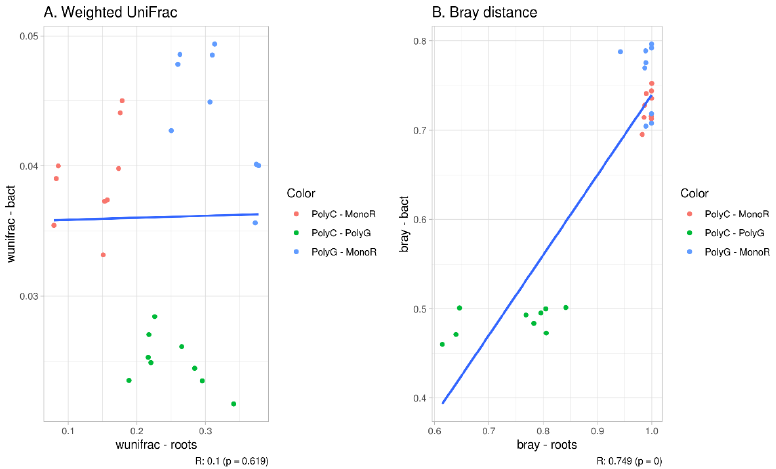
Figure 5. Correlation between beta-diversity indices. ( A ): Weighted UniFrac; ( B ): Bray